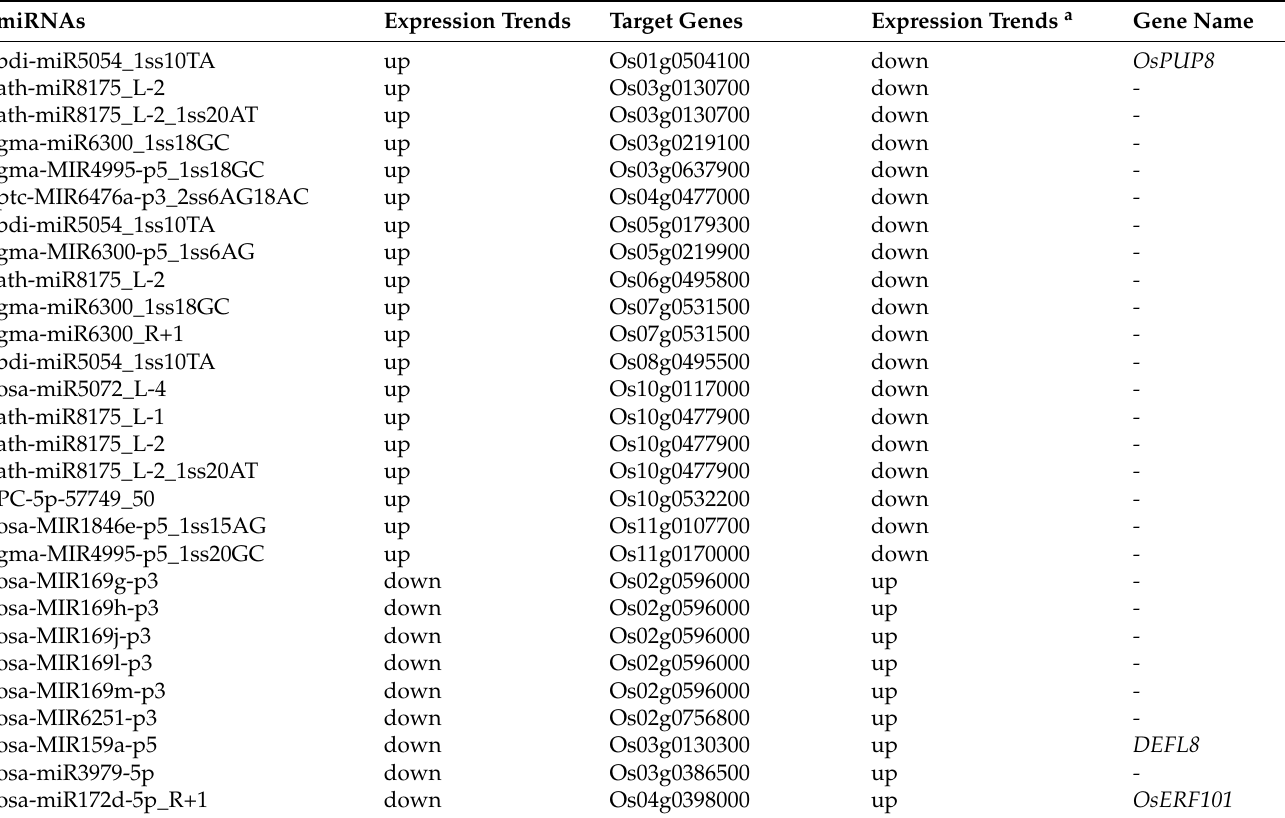
Figure 4. Gene ontology classification of the targeted genes of salt stress-responsive miRNAs. Table 2. miRNA–mRNA pairs showed the opposing expression under salt stress condition in